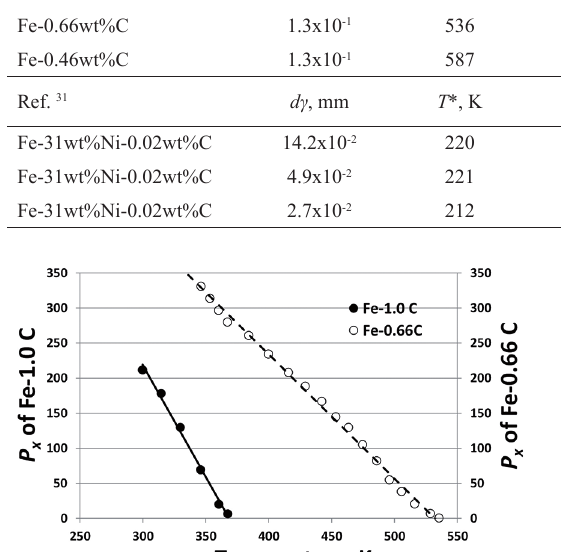
Figure 6: Temperature variation of the autocatalytic factor P